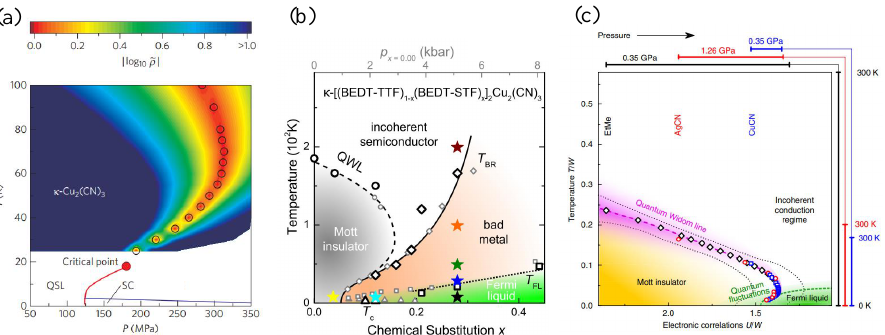
Figure 4. Finite temperature phase diagram of the Mott organic materials. ( a ) first-order phase transition line, as observed in κ -Cu 2 (CN) 3 (adapted with permission from Ref. [25] Copyright 2015 Springer Nature) at T < T c ∼ 20 K , displaying “Pomeranchuk” behavior [45], by “sloping” towards the metallic phase. The corresponding “Quantum Widom Line” [43] arises at T > T c , which is identified as the center of the quantum critical region [46] with resistivity scaling [25]. ( b ) Phase diagram [44] for κ -Cu 2 (CN) 3 over a broader T -range, displaying the convergence of the quantum Widom line (QWL) on the insulating side, and the “Brinkman-Rice” line ( T BR = T max , which intersect at the critical end-point T = T c . The Fermi-Liquid line T FL < T BR is also shown. ( c ) The universal phase diagram for a series of spin-liquid Mott organics compounds was established [42] by rescaling the temperature T and the interaction strength U by the respective electronic bandwidth W . The parameters W and U were independently measured [42] for each material using optical